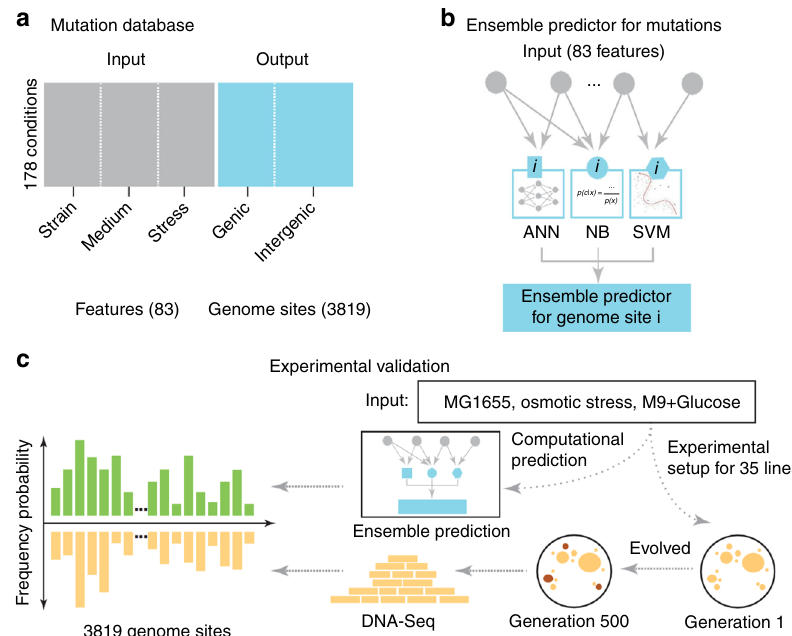
Fig. 1 Overview of predicting mutations in E. coli using a data-driven approach. a A compendium was constructed with mutation pro fi les across 178 conditions over 83 features that capture attributes related to the strain, medium and stress from experiments reported in 95 publications. b We built three individual predictors, namely an Arti fi cial Neural Network (ANN), Support Vector Machines (SVM) and a Naive Bayes (NB) model, which are integrated under one Ensemble method. c Assessment of the predictions from all three individual predictors and the Ensemble method is performed through forward validation over a novel experimental setting through the evolution and whole-genome resequencing of 35 cell